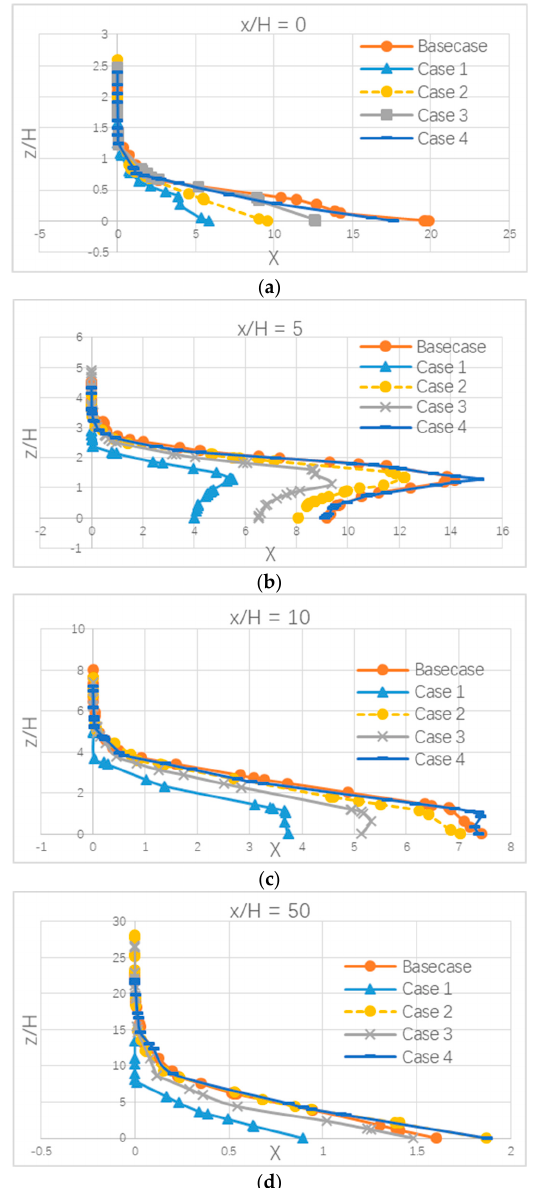
Figure 11. Vertical distribution of CO normalized concentration at different locations (H = 6 m). ( a ) x/H = 0: on the highway; ( b )( c ) x/H = 5, 10: near the highway; ( d ) x/H = 50: far downstream. The horizontal axis in Figure 11 is the normalized concentration. The value of the normalized concentration decreased from the location x/H = 0 to 50. It implied that the emission was mostly on